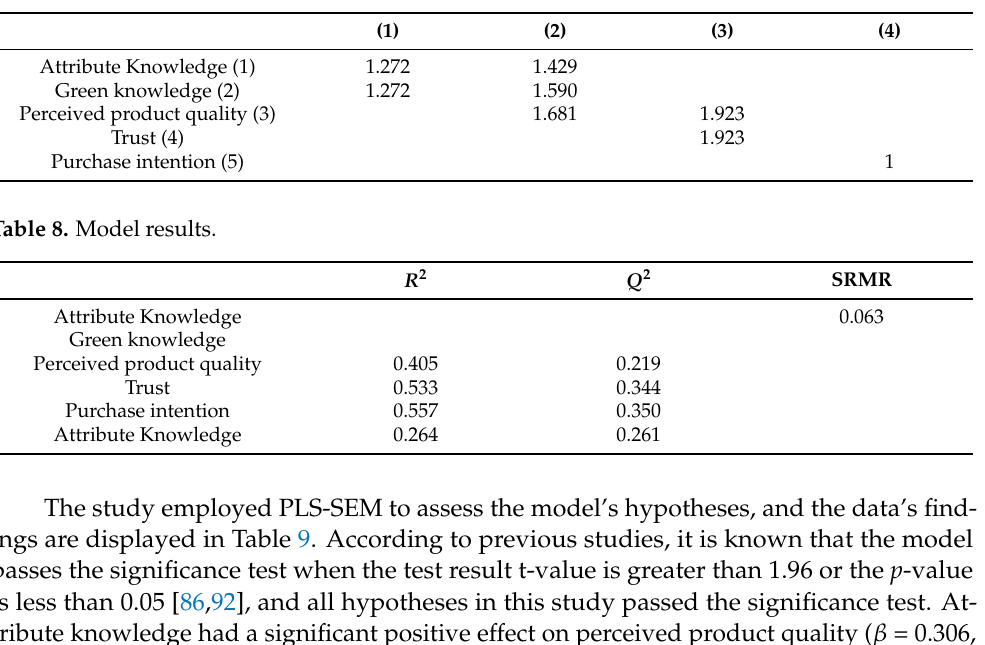
Table 7. Internal model VIF values.